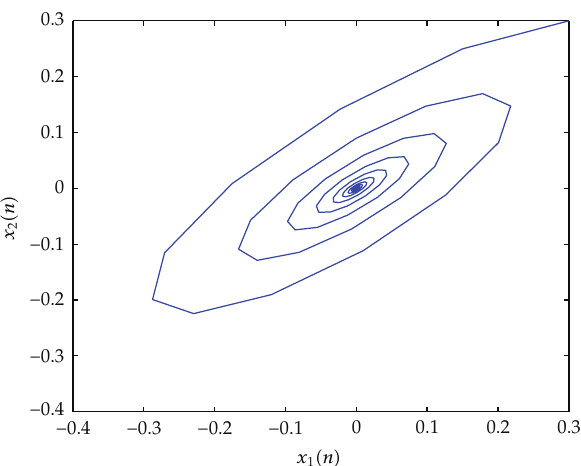
Figure 3: The equilibrium (cid:2) 0 , 0 (cid:3) is asymptotically stable. The initial value and parameter D are (cid:2) 2 , 3 (cid:3) and 38 / 15,